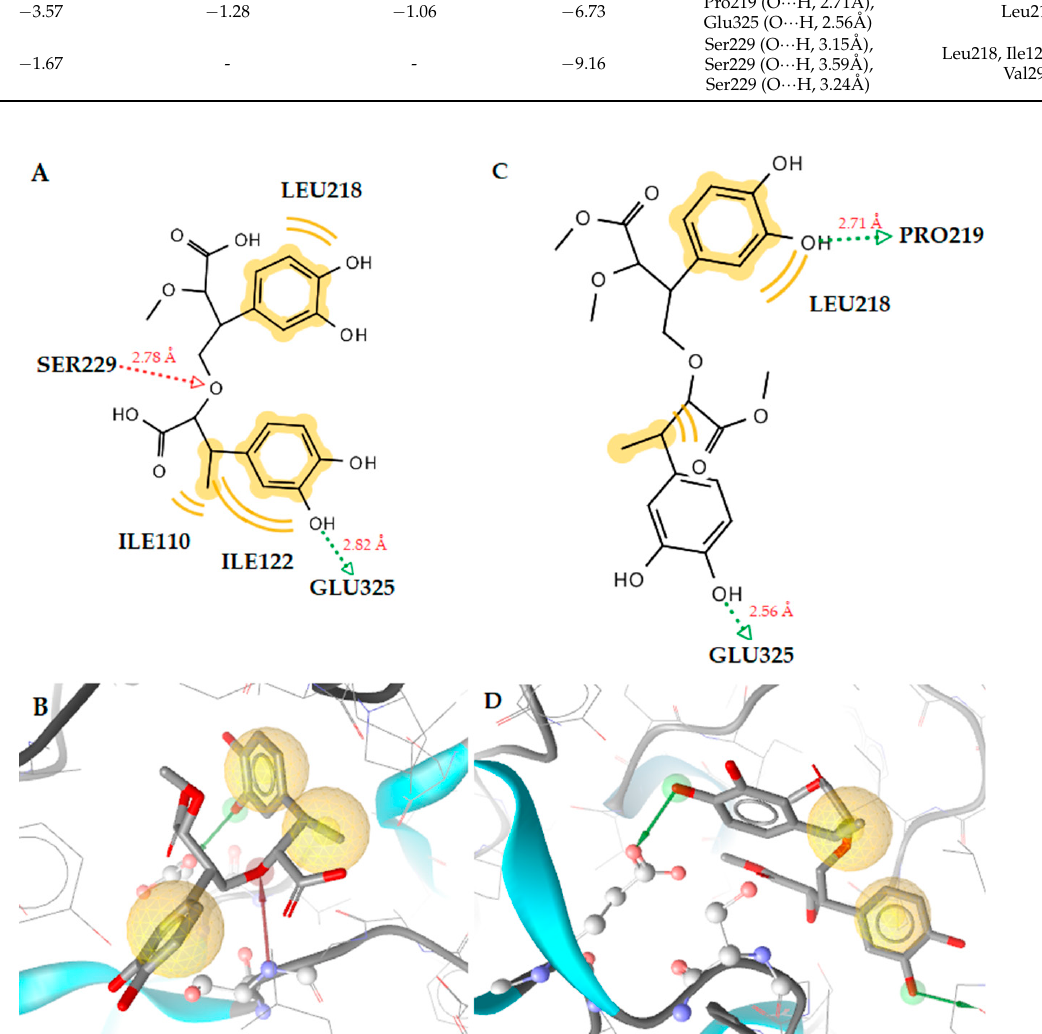
Figure 3. ( A ) A 2D diagram of dimer molecule 1 in E. coli MurB. ( B ) Docked pose of dimer molecule 1 in E. coli MurB. ( C ) A 2D diagram of dimer molecule 2 in E. coli MurB. ( D ) Docked pose of dimer molecule 2 in E. coli MurB. Red and green dotted lines show the hydrogen bonds. Yellow spheres represent hydrophobic interactions.